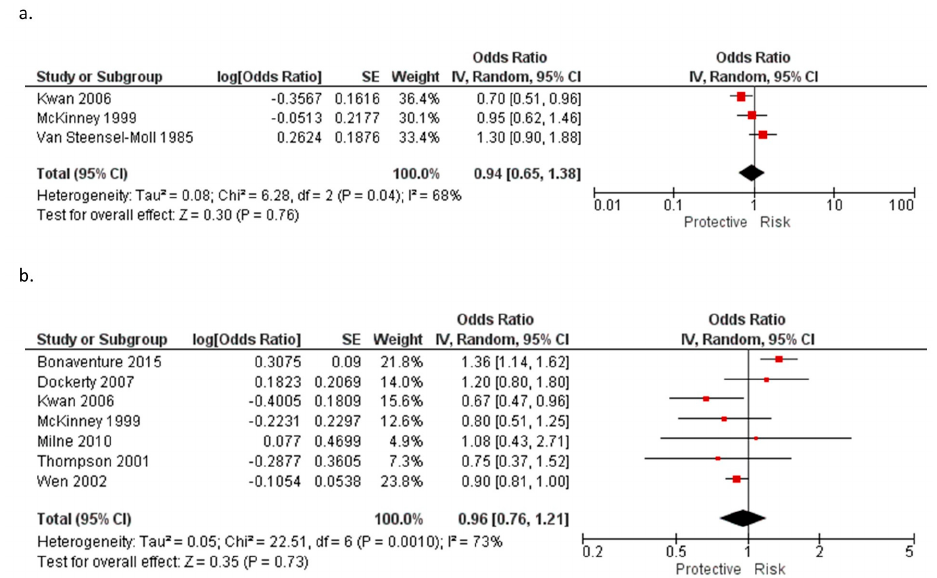
Figure 3. Meta-analysis of the association between the supplementation with folic acid during preg- nancy and ( a ) acute leukemia, ( b ) acute lymphoblastic leukemia and ( c ) acute myeloid leukemia. Note: the individual estimate (OR) from the studies are represented by the red box, and the black diamond represent the estimate of the meta-analysis.